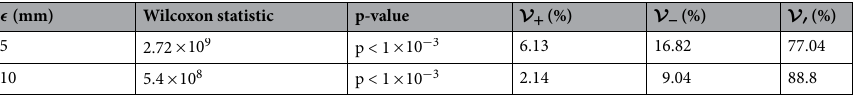
2 ◦ C − 1 : ( a ) Layer 1, ( b ) Layer 2, ( c ) Layer 3